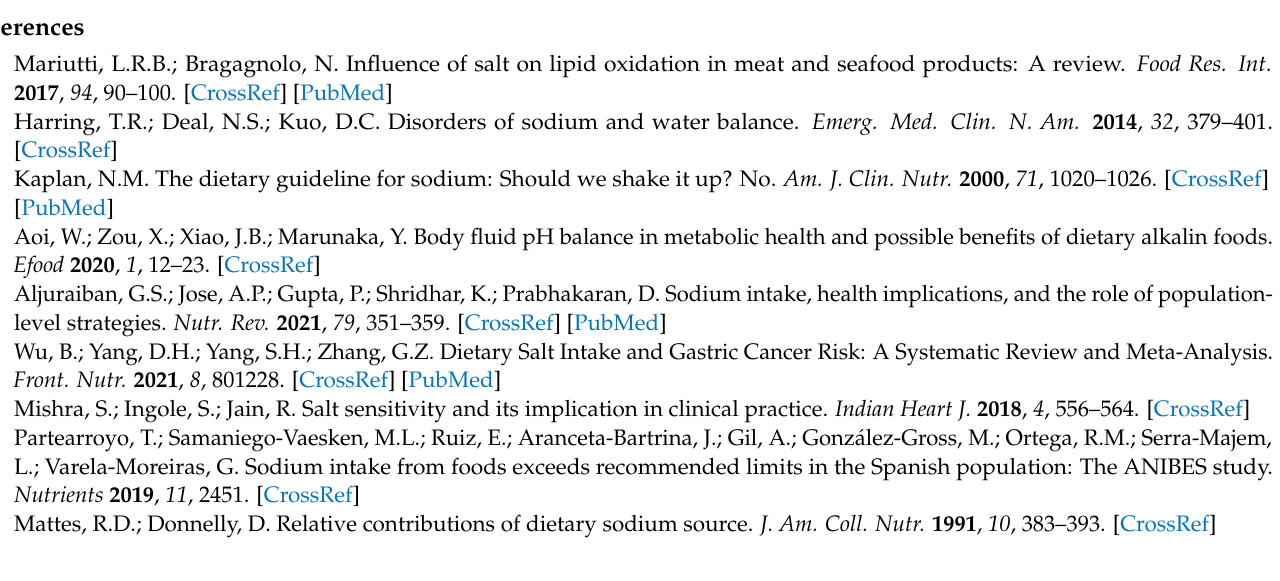
ICP-OES measurement conditions.; Table S3: Food groups and categories of commercial foods; Table S4: Detailed information on different brands; Table S5: Daily intake limitation of food groups; Table S6: Combinations of dietary choices on pre-packaged